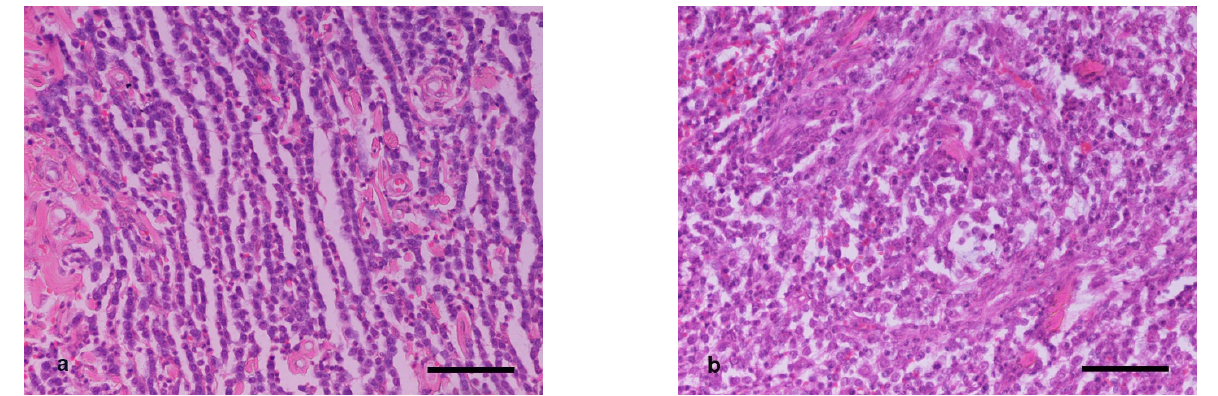
Figure 1. H&E staining ( a ) Low-grade canine MCT from a H2a sample (surface layers). Well-differentiated neoplastic mast cells with minimal pleomorphism and low mitotic index arranged in rows. ( b ) High-grade MCT from the H2b area (center of the excised mass) of the same case as in ( a ). Increased anisokaryosis and mitotic index of neoplastic mast cells. Scale bar: 100 μ m.